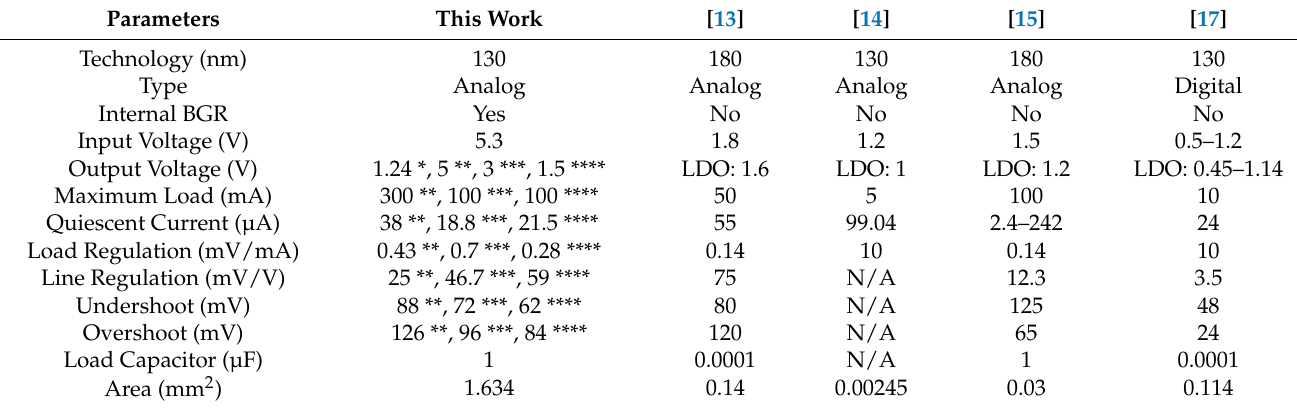
Table 1. Performance